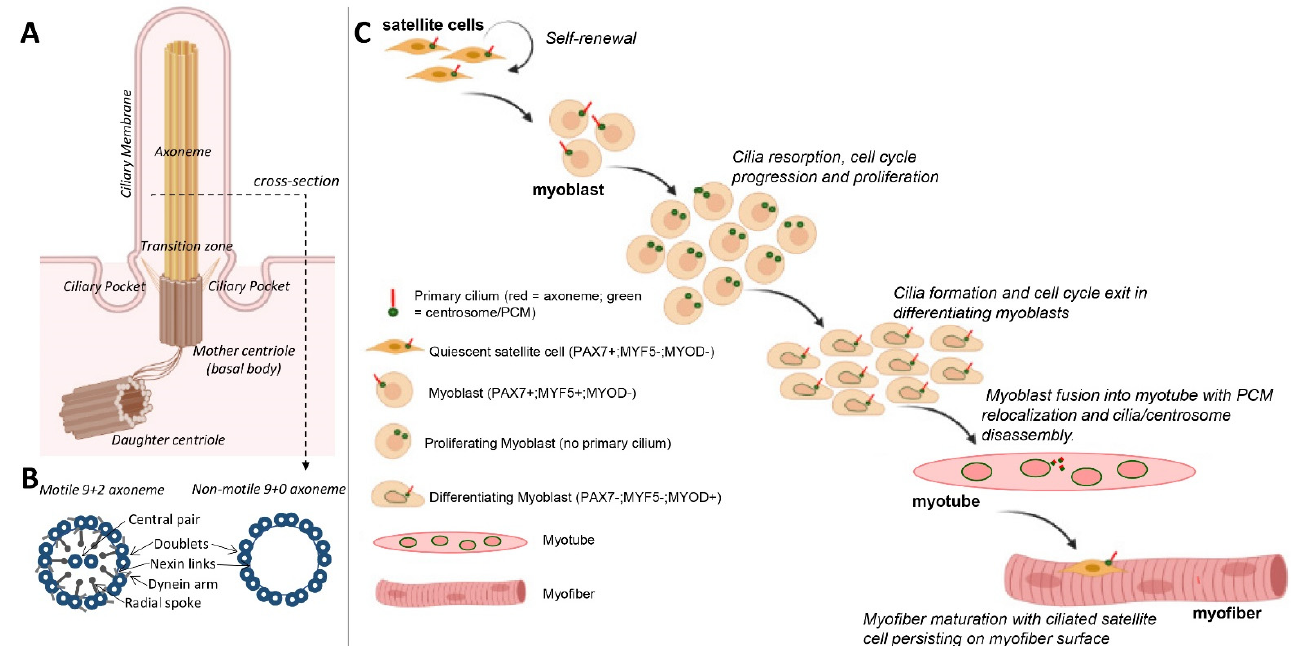
Figure 1. Primary cilia assembly and disassembly during myogenesis. ( A ) The mother centriole with distal appendages forms the basal body of primary cilia. The distal appendages delineate a transition zone and a ciliary compartment distinct from the cytoplasm. Axonemes are comprised of bundles of microtubules that extend upwards from the basal body and are encased in a ciliary membrane. ( B ) Cross-sectional view of axoneme. Motile cilia possess a 9 + 2 radial configuration of axonemal microtubules. Outer doublet microtubules are connected by nexin links and interact with central single microtubules via radial spoke complexes. Non-motile primary cilia in muscle are organised in a 9 + 0 configuration. ( C) Cilia formation and resorption during myogenesis. Satellite cells expressing PAX7 (PAX7 +ve ) are ciliated, and these are resorbed as satellite cells specify proliferative myoblasts that express Myf5. Cilia are briefly reassembled in myoblasts as they downregulate PAX7, upregulate MYOD (MYOD +ve ) for differentiation and exit the cell cycle. During late stage differentiation and fusion into myotubes, cilia are disassembled, and centrosomes undergo reduction. Cilia are largely absent in mature myofibers but found on quiescent satellite cells located between the myofiber and basal lamina.